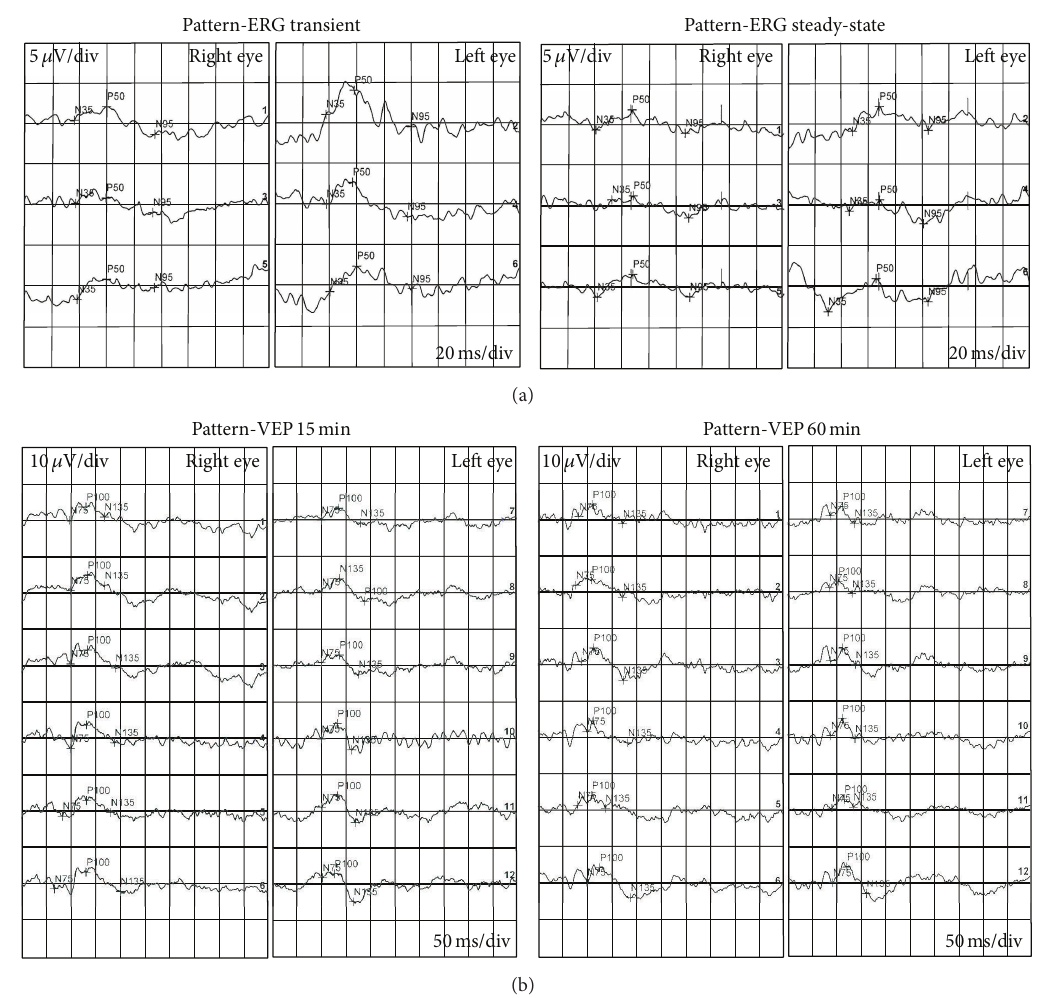
Figure 2: (a) Pattern electroretinography showing delayed P50 and N95 implicit times and only mild reduction in amplitude. (b) Pattern visual evoked potential showing significant reduction in